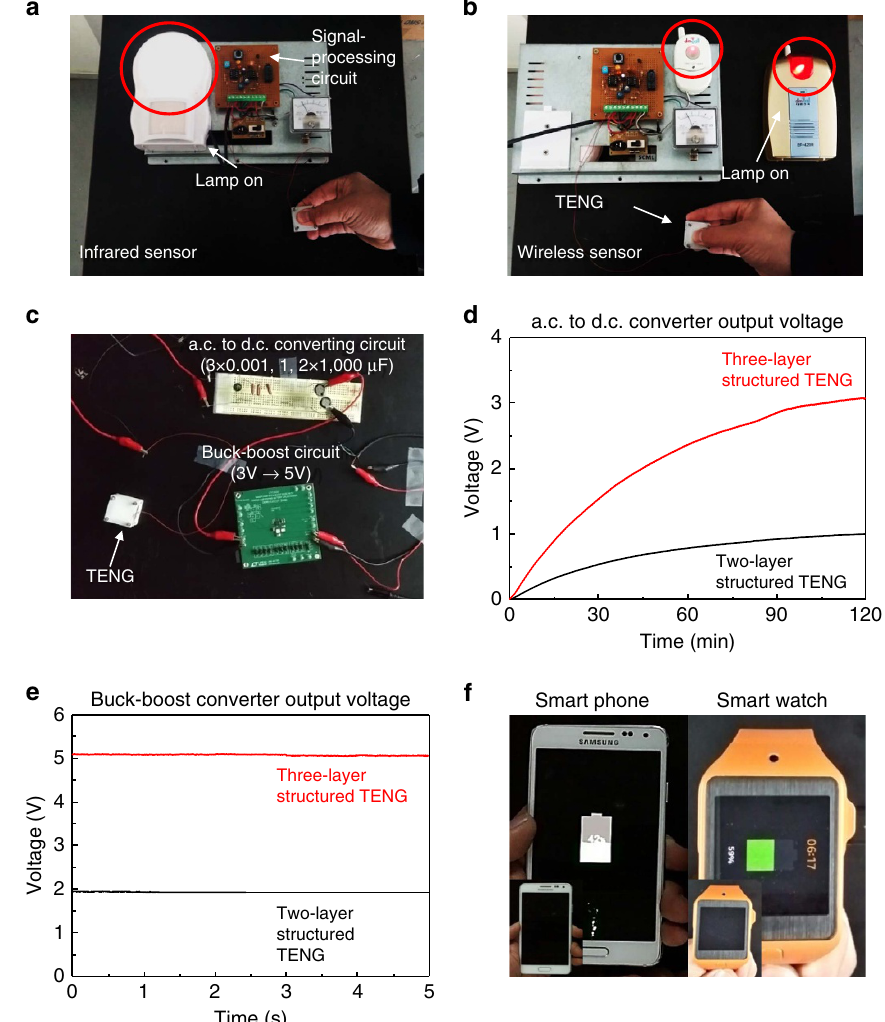
Figure 6 | Wireless sensing system and portable power-supplying system for driving and charging electronics. ( a ) Optical images of the infrared sensor and ( b ) the wireless sensor operated by the integrated wireless sensing system with a signal-processing circuit. ( c ) Optical images of the portable power-supplying system with an a.c. to d.c. converting circuit and a buck–boost circuit. ( d ) Measured output voltages in a a.c. to d.c. converter and ( e ) a buck–boost converter. ( f ) Optical images of charging a battery of smart